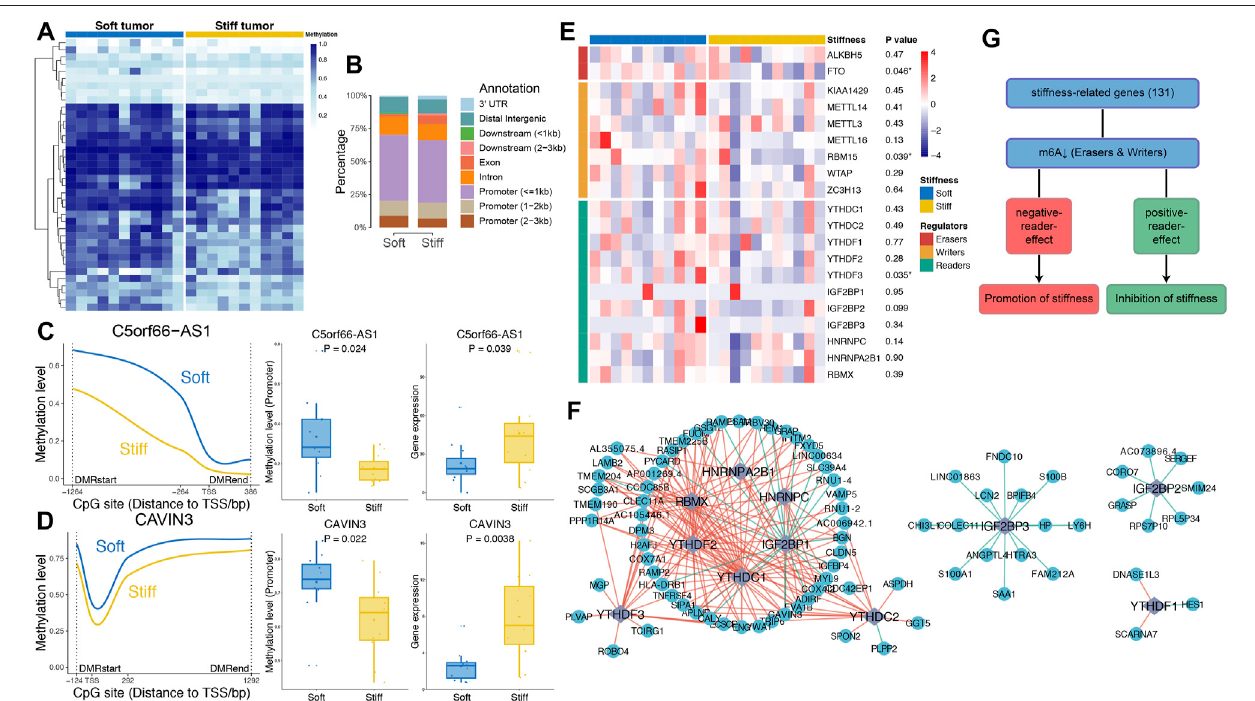
FIGURE 4 | Associations of DNA methylation and m6A RNA methylation with the stiffness of PAs. (A) Heatmap illustrating the 38 DMRs between soft and stiff tumors. (B) Comparisons of hypermethylated DMRs between soft and stiff tumors. (C,D) Left panel: Comparisons of the methylation levels of CpG sites within the DMRs of promoter regions between soft and stiff PAs. Middle panel: Comparisons of the methylation levels of promoter regions between soft and stiff PAs. Right panel: Comparisons of the gene expression levels between soft and stiff PAs. (E) Heatmap comparing 20 m6A regulators between soft and stiff tumors. (F) Analysis of the correlation between reader and SRG expression. Blue dots represent SRGs, and purple rhombi represent readers. Red lines represent negative correlations,and greenlines represent positivecorrelations. (G) The overallroleofm6Ain regulatingthe stiffnessofPAsisbelieved tobetwo-sided, includingpromotion and inhibition of